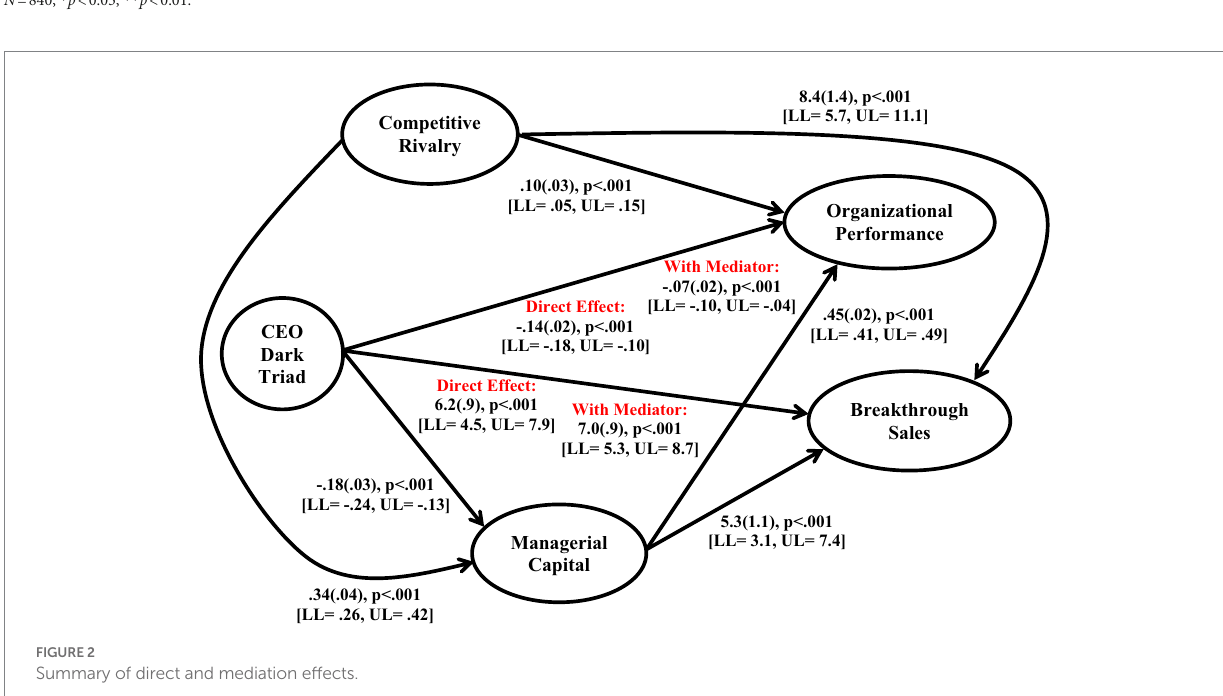
FIGURE 2 Summary of direct and mediation